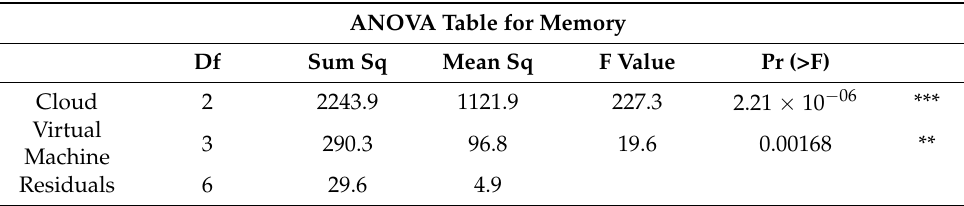
Table 7. ANOVA Table for Memory on clouds for different virtual machines.